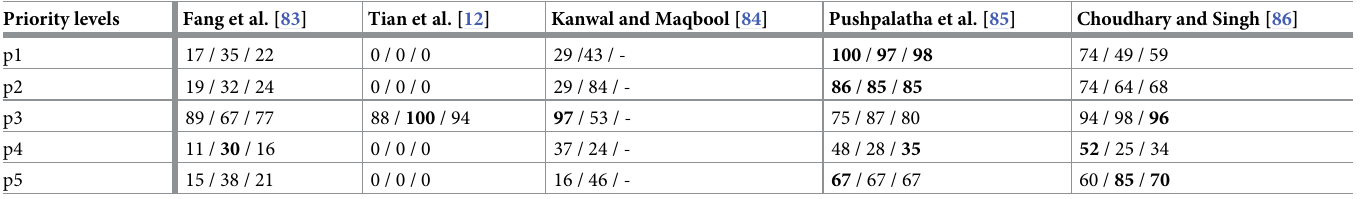
Table 6. Comparison of methods predicting priority. Priority levels are from Bugzilla [47]. The performance is described as precision/recall/f-score with the best results highlighted in bold. All data are shown as percentages. Priority